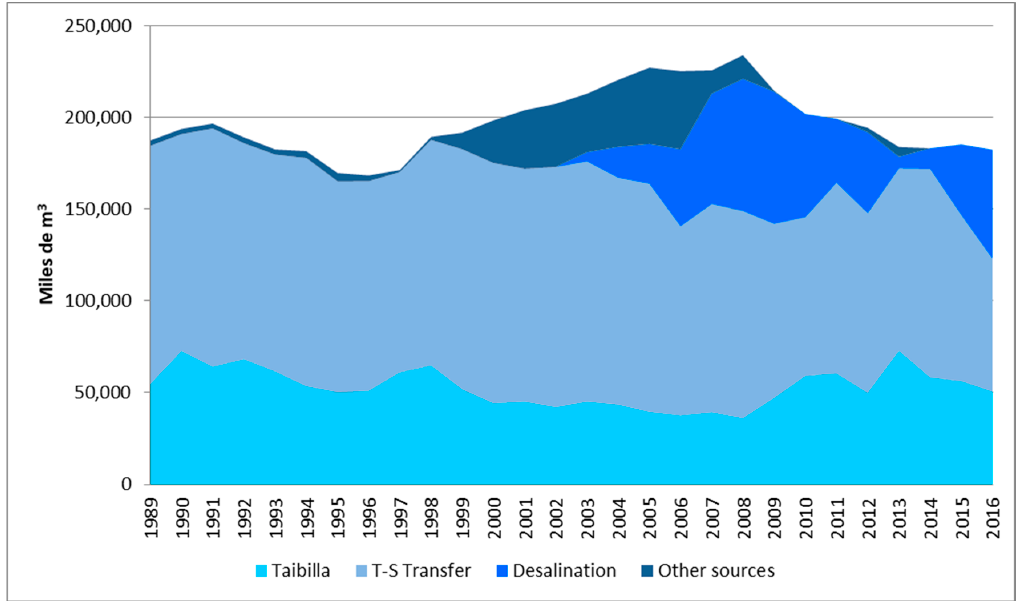
Figure 7. Origin of the different sources of the MCT.